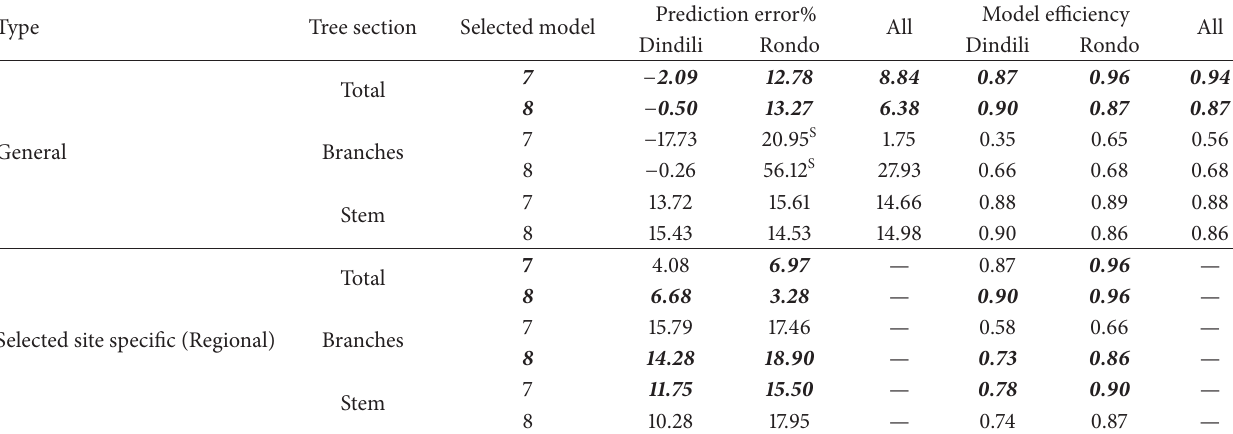
Table 4: Evaluation of the selected general and site specific models for tree total, branches, and stem volume. Type